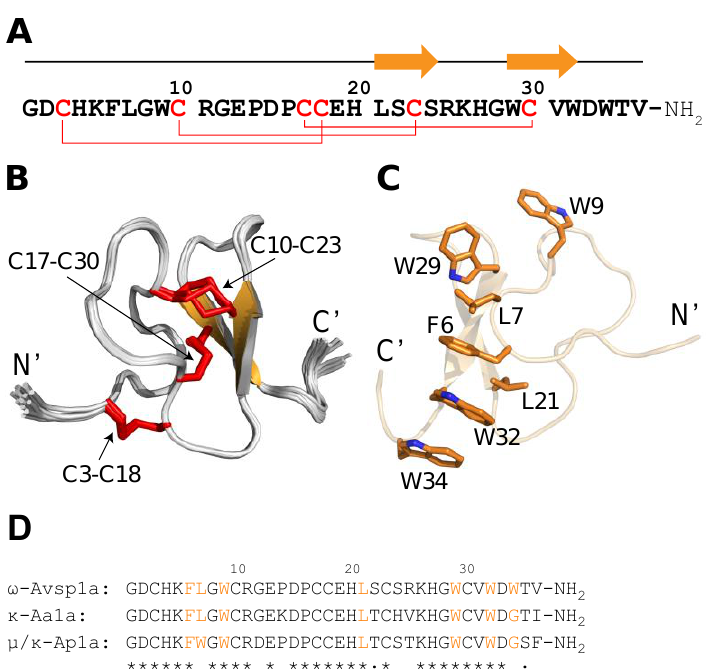
Figure 8. Structure of ω -Avsp1a. ( A ) Primary and secondary structure of ω -Avsp1a. Disulfide bonds are indicated by red lines and the secondary structure of the peptide is shown above the sequence, with orange arrows representing β -strands. ( B ) Ensemble of 20 ω -Avsp1a structures determined using solution-state NMR spectroscopy. β -strands are orange and disulfide bonds are indicated by red tubes. The N- and C-termini and disulfide bonds are labelled. ( C ) Structure of ω -Avsp1a highlighting the ladder of hydrophobic residues. The sidechains of the seven residues that contribute to this hydrophobic ladder (F6, L7, W9, L21, W29, W32 and W34) are shown as orange tubes. ( D ) Sequence alignment of the three C-terminally amidated Avicularia toxins ω -Avsp1a, κ -Aa1a and µ / κ -Ap1a made using CLUSTAL Omega 1.2.4 (www.ebi.ac.uk/Tools/msa/clustalo/; accessed on 1 May 2022). The seven hydrophobic residues specified in ( C ) are highlighted in orange in ( D ). Amino acid sequence conservation is indicated by (*) = fully conserved residues, (:) = conservation of residues with strongly similar properties, (.) = conservation of residues with weakly similar properties.